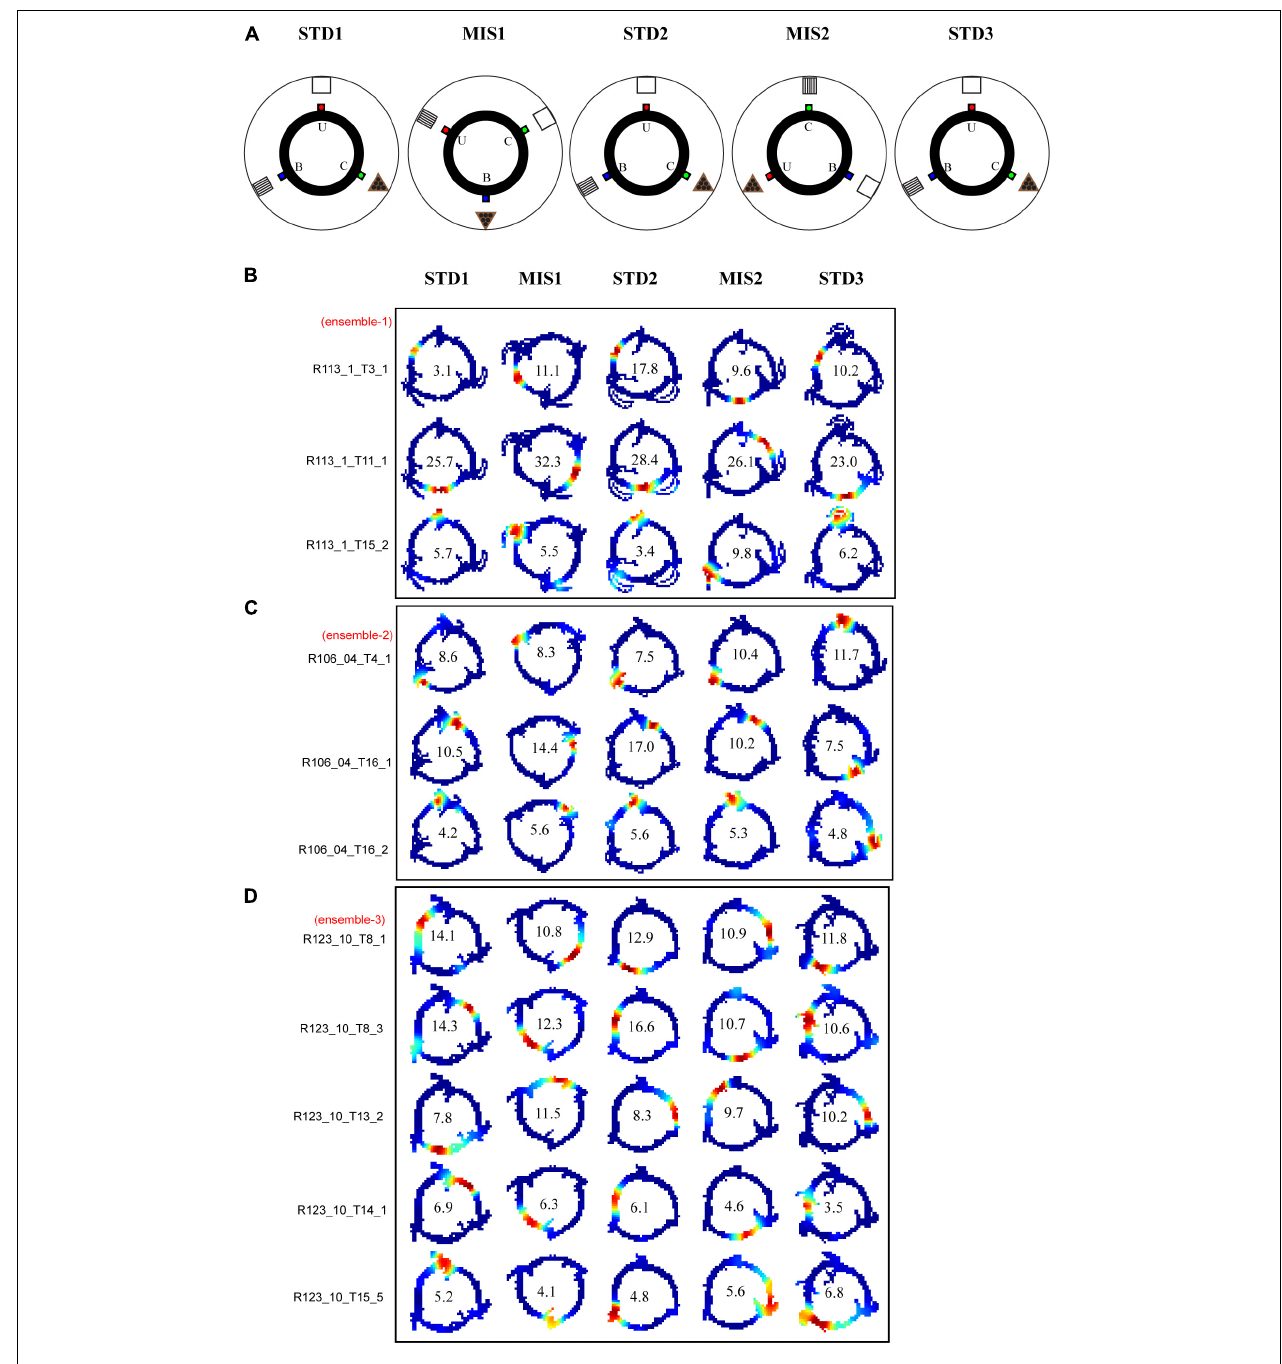
FIGURE 7 | Schematic representation of double rotation experiments with different reward flavors as local cues (RwdFlav). (A) The schematic representation of the double rotation paradigm using rewards of different flavors as local cues. The blue dot indicates the spoke where banana flavor pellets (B) were provided, the red dot indicates the spoke where sucrose pellets (U) were provided, and the green dot indicates the spoke where chocolate-flavored pellets (C) were provided. (B–D) Representative place fields from different experimental days from five sessions. On the left side, cluster-ID is provided. The number inside the firing rate maps indicates the peak firing rate in